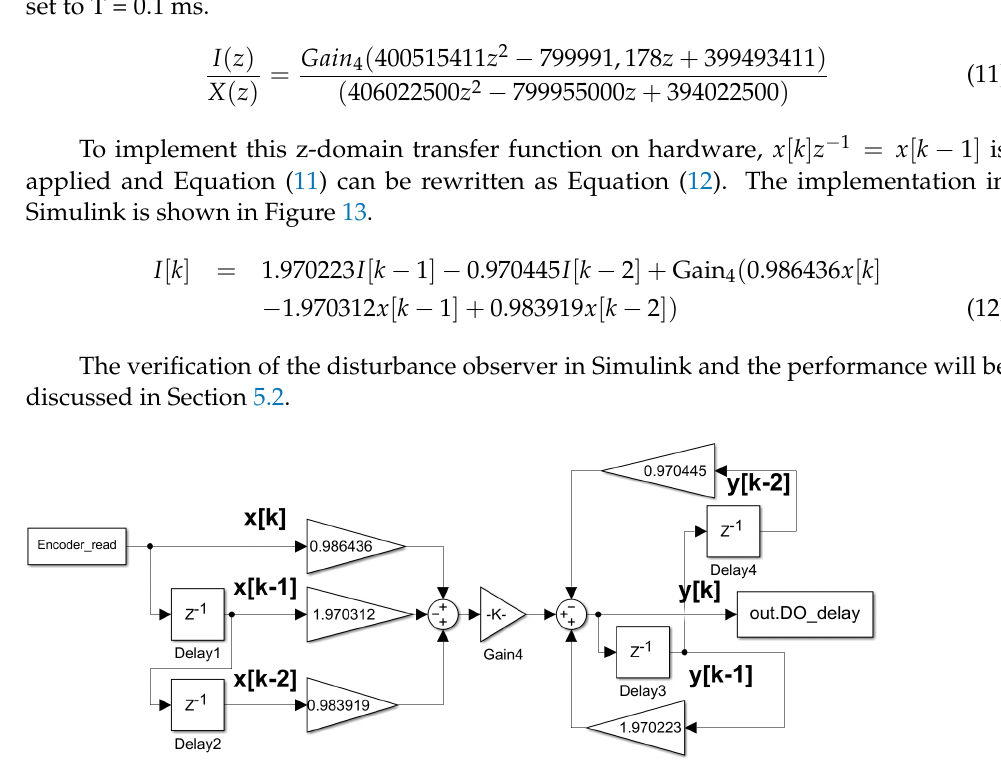
Figure 13. Implementation of disturbance observer in